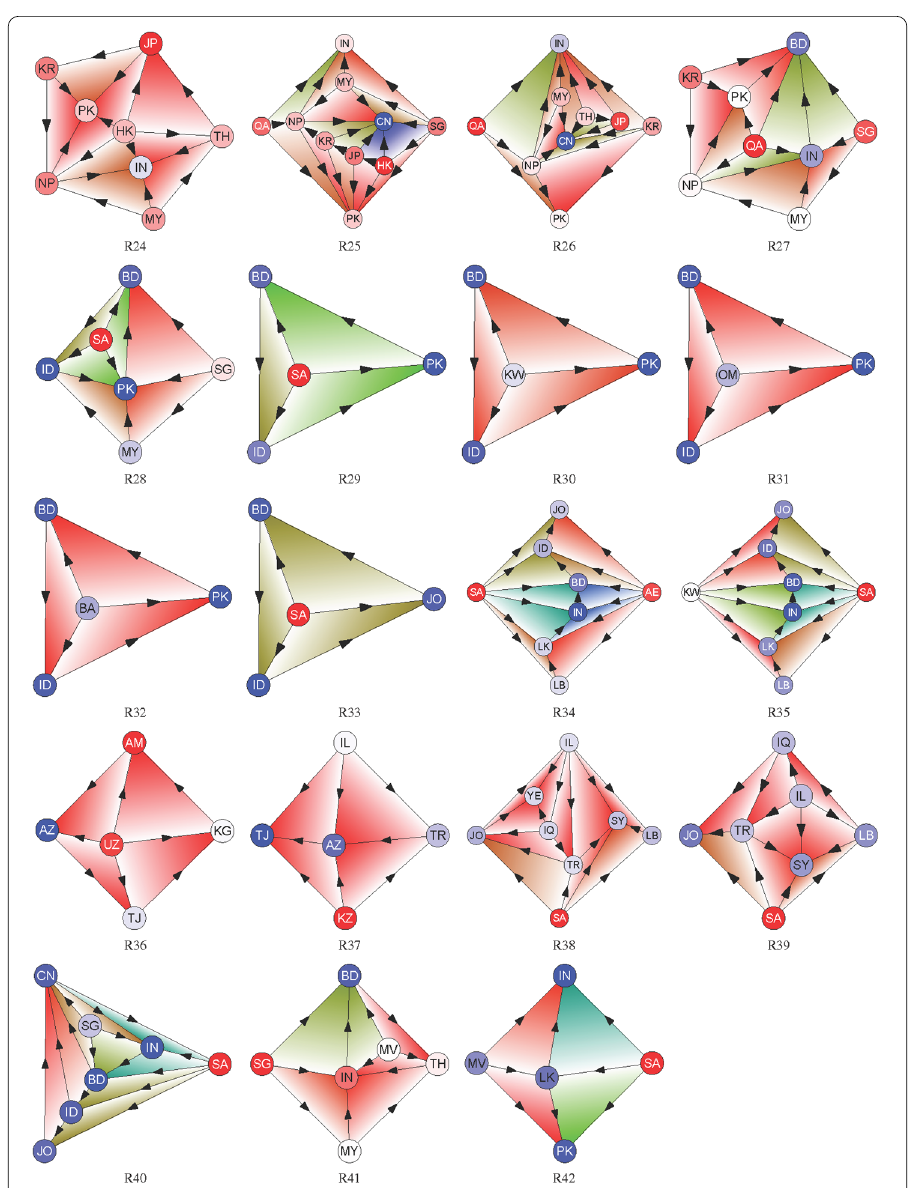
Figure 15 Spherical patterns within the Asian migration and Remittance networks continued. 2-cycle generators for the 2015 Asian net migration (M1-M37) and remittance (R1-R42) networks